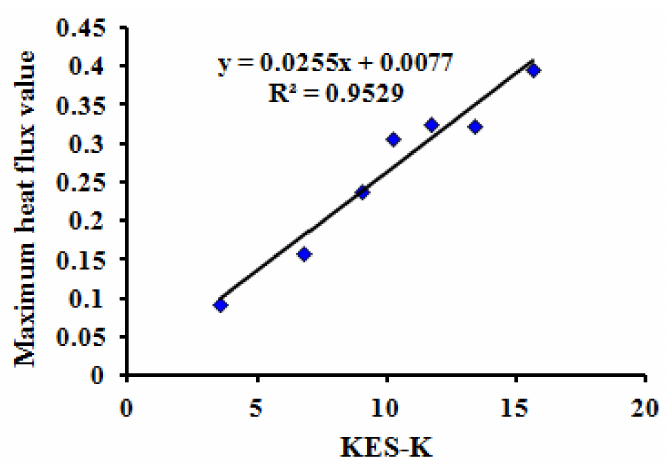
Figure 6. Relationship between maximum heat flux value ( H M ) of MTT test and KES thermal test.